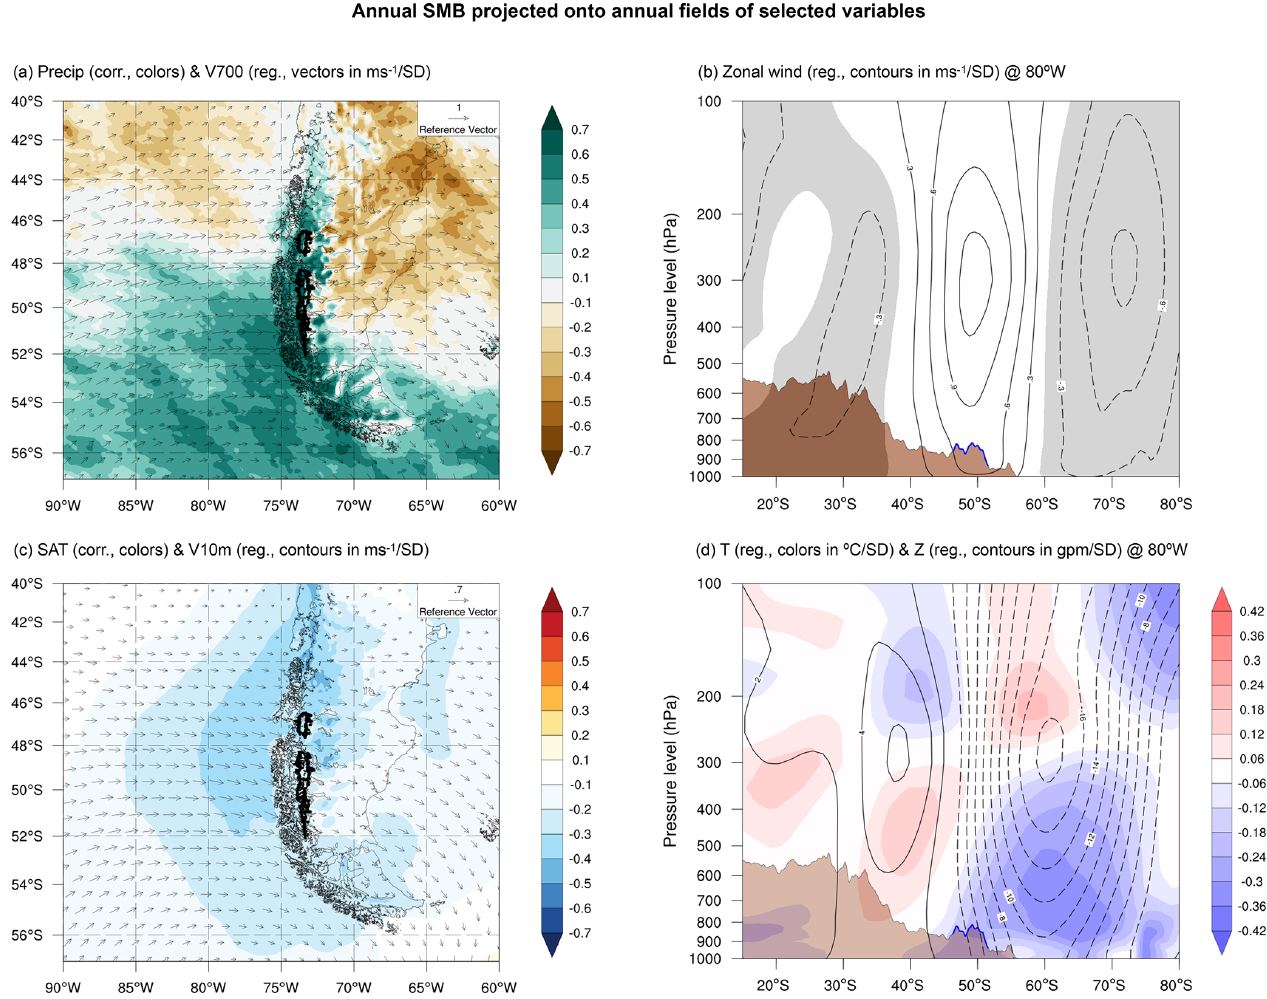
Figure 5. Regional correlation and linear regression maps of the annual (April to March) time series of the spatially averaged field of SMB with fields obtained from the RegCMv4 simulation data and ERA-Interim reanalysis. (a) Regression with annual fields of horizontal wind at 700hPa (vectors in ms − 1 per SD) and correlation with accumulated precipitation (colors). Fields were obtained from the RegCMv4 data. (b) Latitudinal and atmospheric profile of the regression with annual field of zonal wind (contours in ms − 1 per SD) for a transect at 80 ◦ W. Negative regression values are shaded, and the Andes topography within the latitudinal band of the Patagonian Icefields is shown with blue lines. Fields were obtained from the ERA-Interim reanalysis. (c) Regression with annual fields of horizontal wind at 10m above ground level (vectors in ms − 1 per SD) and correlation with the mean near-surface air temperature (colors). Fields were obtained from the RegCMv4 data. (d) Latitudinal and atmospheric profile of the regression with annual field of geopotential height (contours in gpm per SD, where gpm stands for geopotential meter) and temperature (colors in ◦ C per SD) for a transect at 80 ◦ W. The Andes topography within the latitudinal band of the Patagonian Icefields is shown with blue lines. Fields were obtained from the ERA-Interim